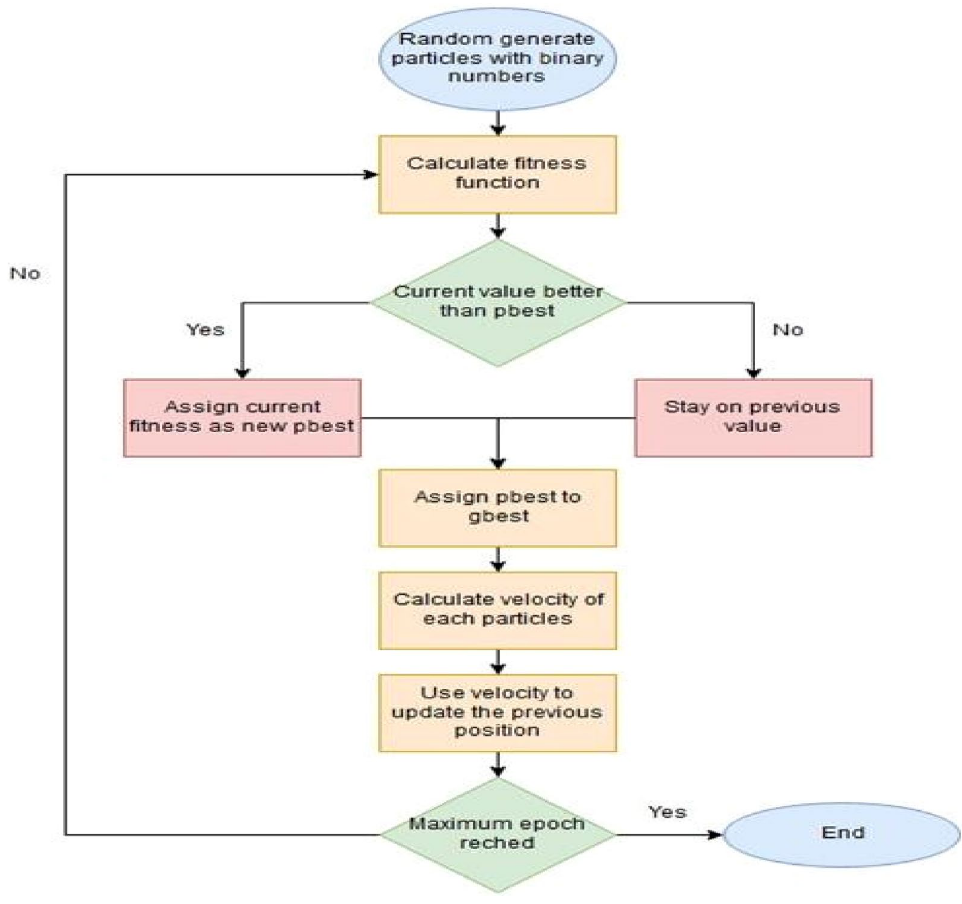
Figure 14. Flow chart of particle swarm